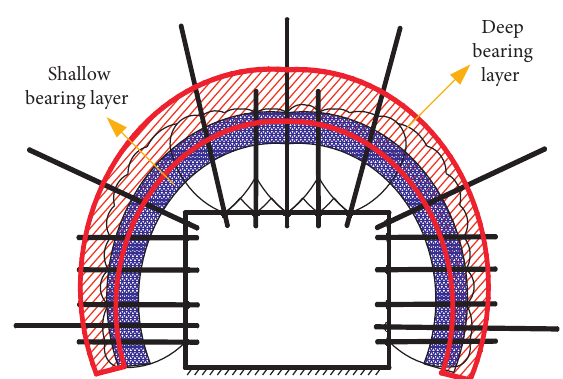
Figure 13: Schematic diagram of bearing